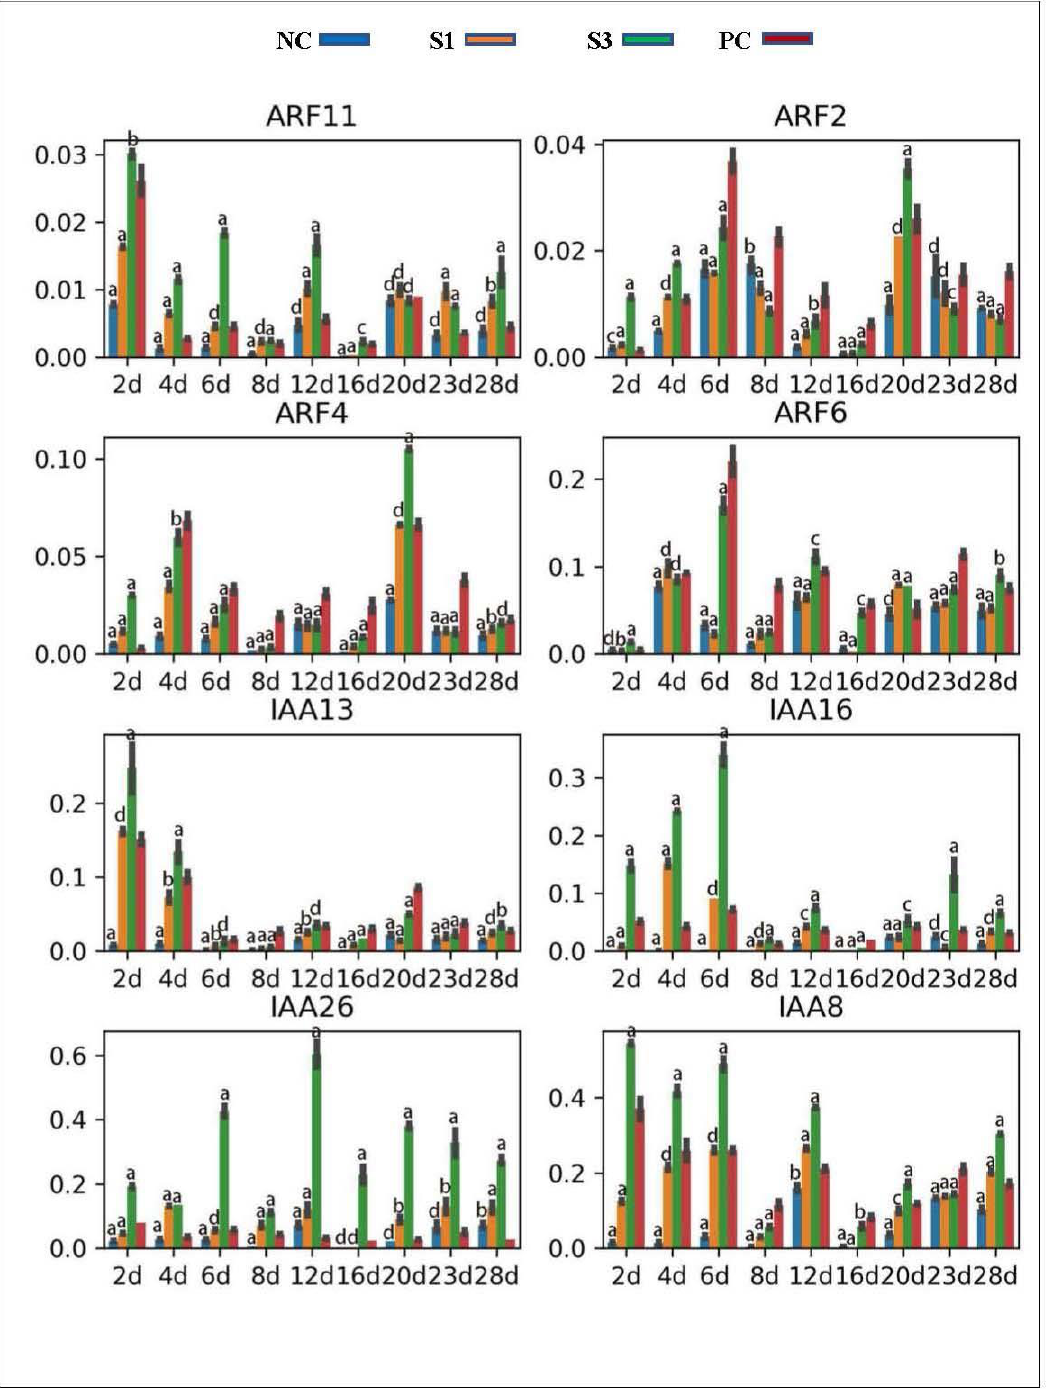
Figure 4. Expression profiles of AUX/IAAs and ARFs in differently treated samples. a, p -value < 0.001; b, p -value < 0.01; c, p -value < 0.05; d, p -value > 0.05.